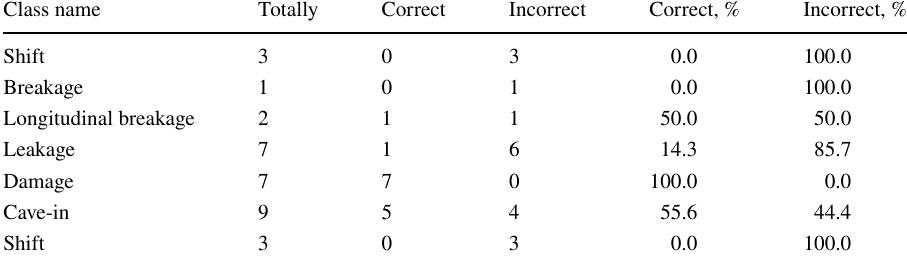
laterals’ damages—model SVM-L, training